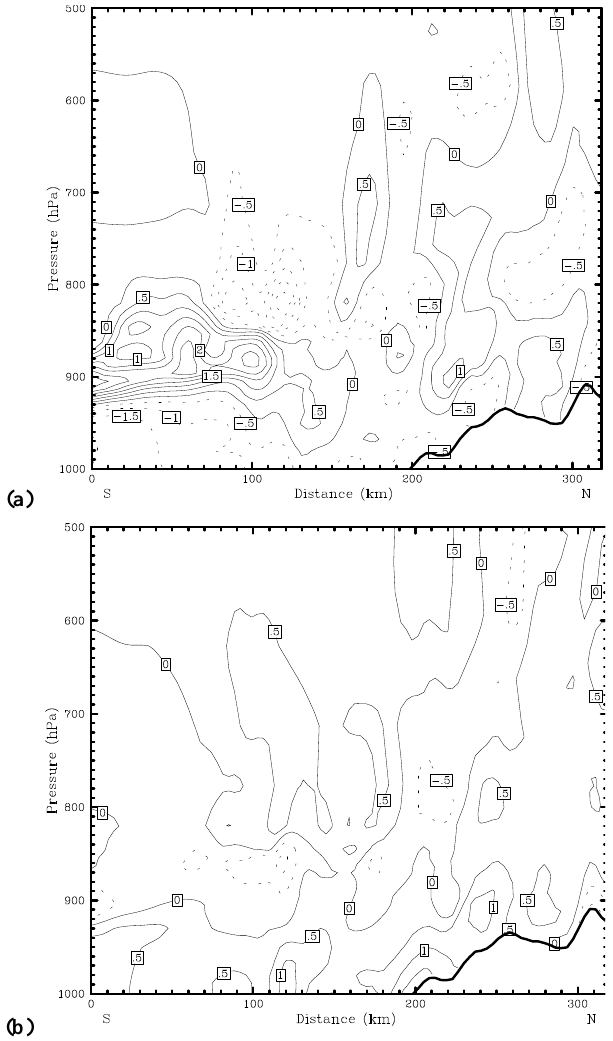
Fig. 10. Vertical cross sections of the potential temperature dif- ferences (K) and water vapor mixing ratio differences (g/kg) for 19 September 1999 at 15:00 UT. Orientation of the cross sections is shown in Fig. 3. Both show intervals of 0.5 units. The thick line represents the topography. (a) Specific humidity difference (MRF- ETA schemes), (b) Potential temperature difference (MRF- ETA